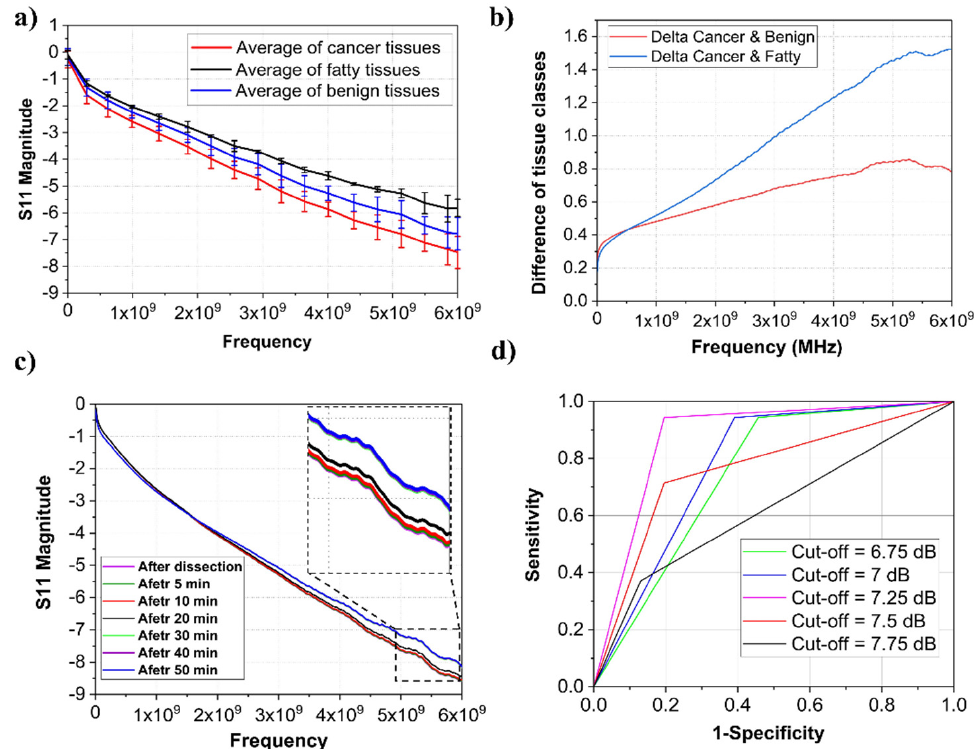
Figure 3. ( a ) mean values of S 11 magnitude in three categories of fatty, benign, and malignant breast tissues. ( b ) Differences of each category versus tumor spectrum. ( c ) Variation of measured S 11 by the time after dissection with magnification. ( d ) The ROC curve for different cut-offs. Table 1. Defining a cut-off value for